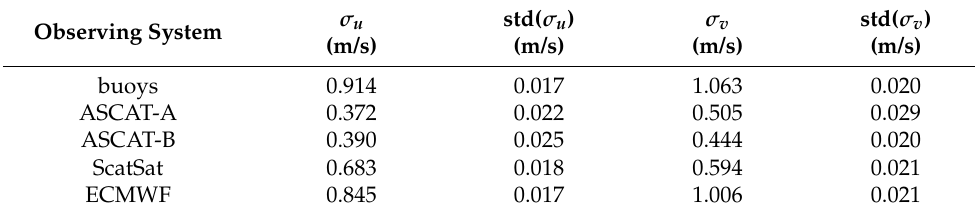
Table 2. Observation error standard deviations and their